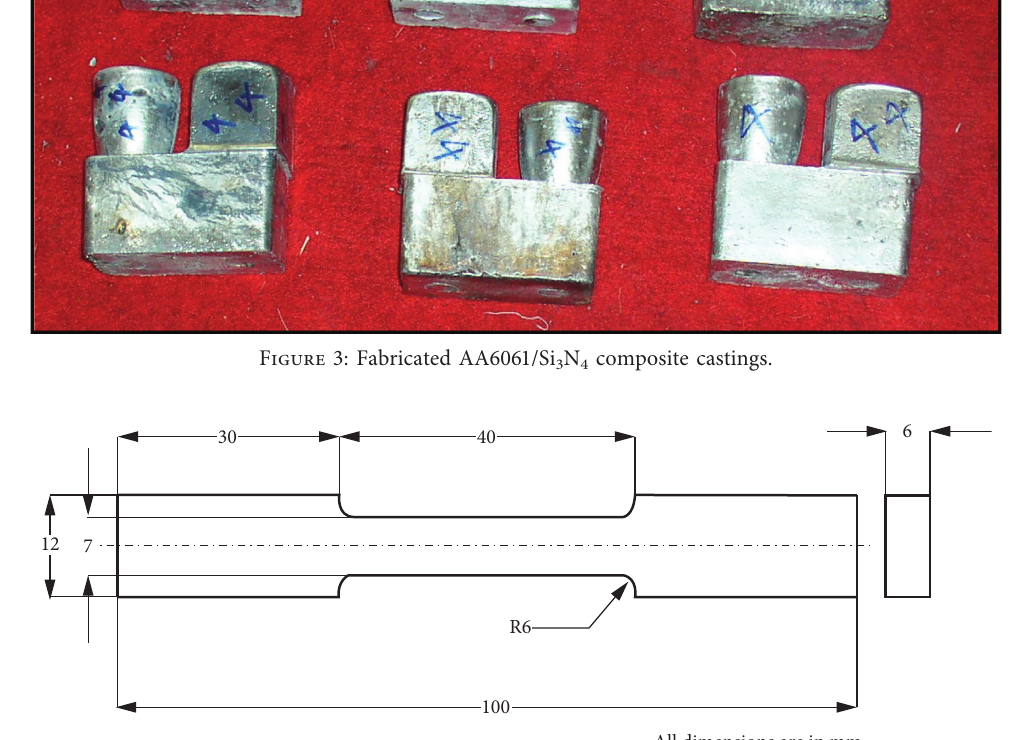
Figure 4: Dimensions of the tensile specimen as per the ASTM: E8/E8 M-11 standard.